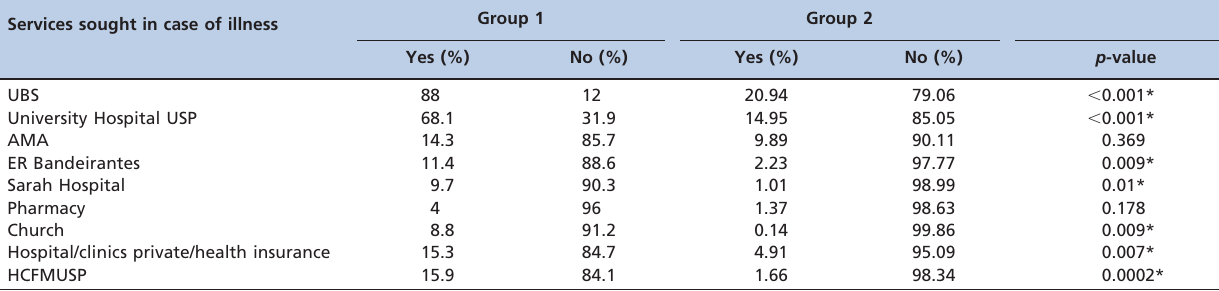
Table 4 - Population’s access to health